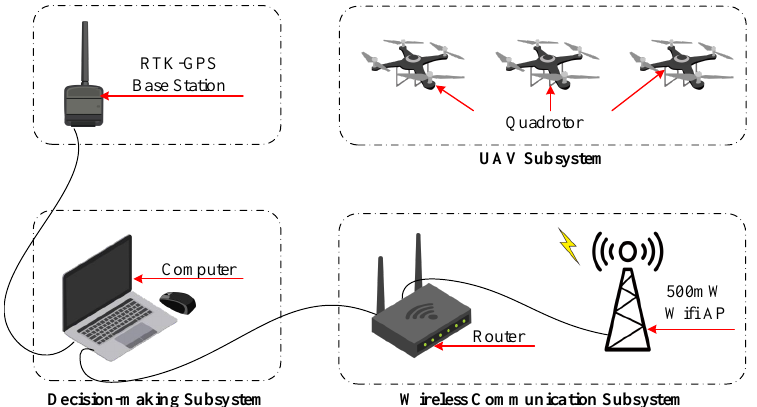
Figure 9. Schematic of the hardware components of the UAV-LS system.